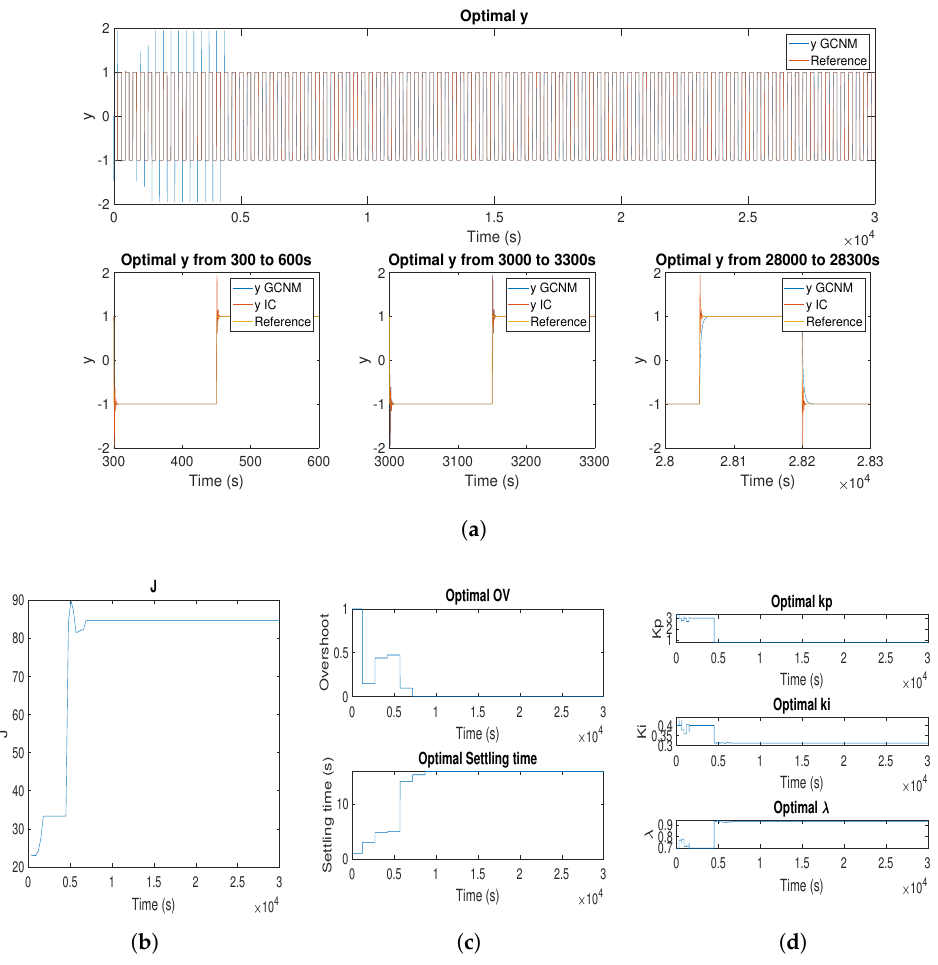
Figure 8. SOC controller: ( a ) time response, ( b ) cost function, ( c ) overshoot and settling time, and ( d ) PI gains evolution for L = 0.1 with H = 0.7. The average performance of the SOC controller with GCNM algorithm for L = 0.1, 1, 10 regarding to the mean overall convergence time, closed-loop settling time, and